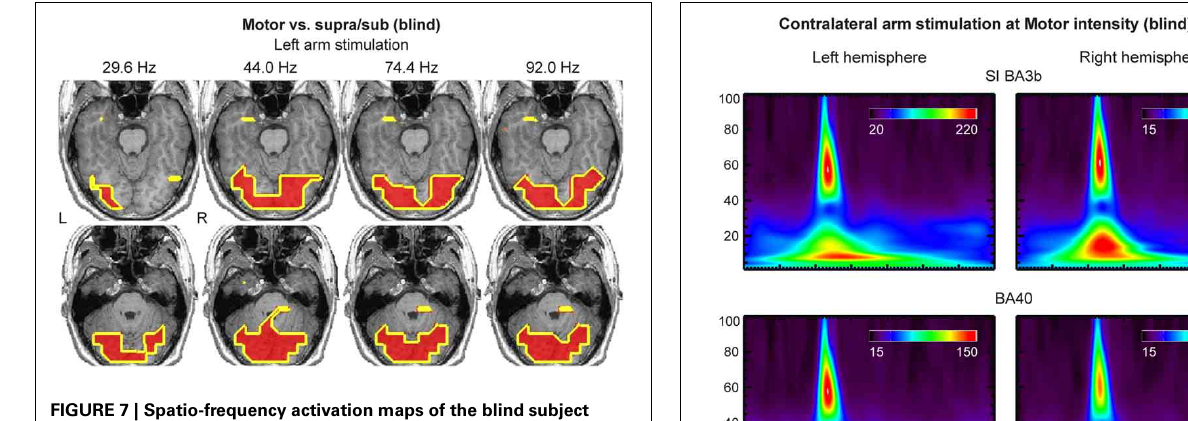
FIGURE 7 | Spatio-frequency activation maps of the blind subject derived from “Motor vs. Supra/Sub” contrast are shown for left arm stimulation at four frequencies (indicated on top of each column). Two axial slices of MRI best covering the visual cortex activations are shown. Yellow contours encompass regions with statistically significant ( P < 0 . 0001) increases in activity.